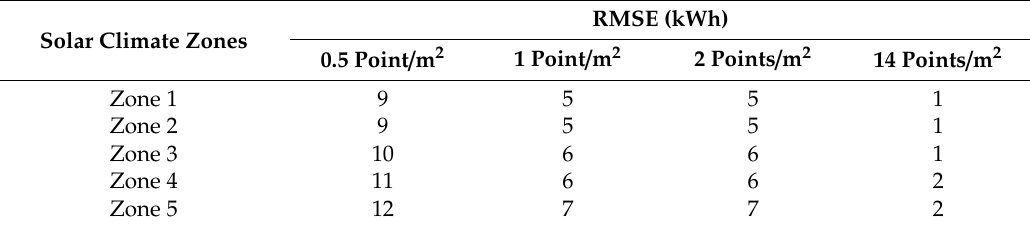
Table 14. Average daily electrical energy loss (kWh) due to the error in the estimation of the rooftop area for di ff erent point cloud densities: industrial buildings with a gable roof of 100 m 2 .